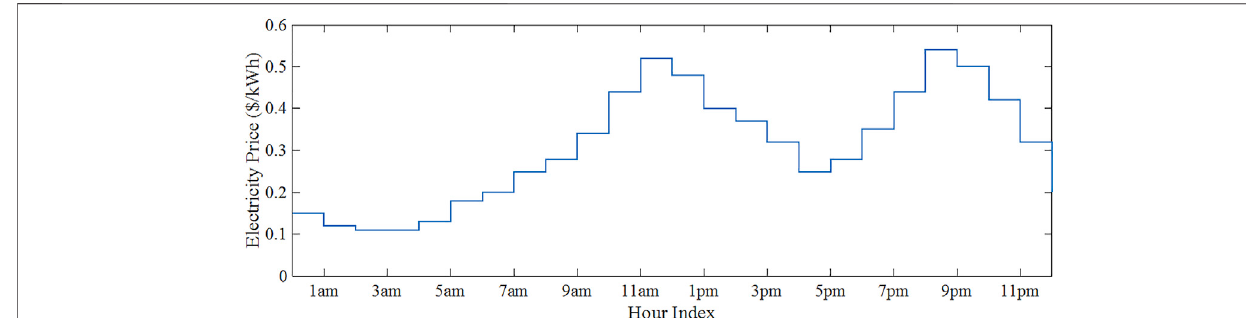
FIGURE 10 | Pro fi le of the real-time electricity prices.